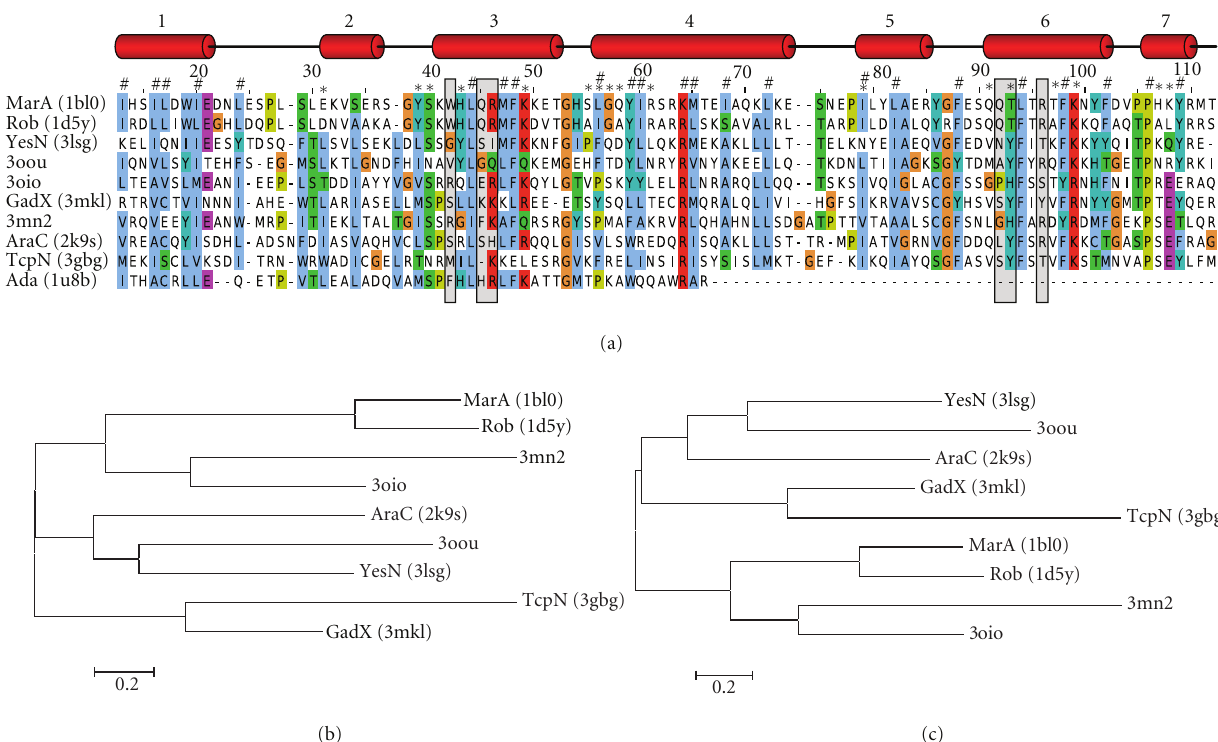
Figure 4: Structure-derived multiple-sequence alignment and dendrogram of known and putative AraC/XylS-family transcription factors. (a) The structures were aligned with SALIGN [16] and a multiple sequence alignment was derived from equivalent residue positions. Secondary structure elements are given at the top. Residues marked with a gray-shaded box are engaged in DNA base interactions, those marked with an asterisk contact the DNA sugar-phosphate backbone, and a hash sign denotes residues of the hydrophobic core. Numbering scheme and annotations are according to MarA protein (PDB code: 1bl0). Colors are as in Figure 2. (b) Maximum likelihood dendrogram derived from the structure-based MSA in (a) generated with the software MEGA5 [20]. Distances in the dendrogram refer to the number of amino acid substitutions per site. Only structures with two HTH domains (omitting Ada) were included. (c) For comparison, a more concise view of the dendrogram in Figure 3 is given, showing only relevant